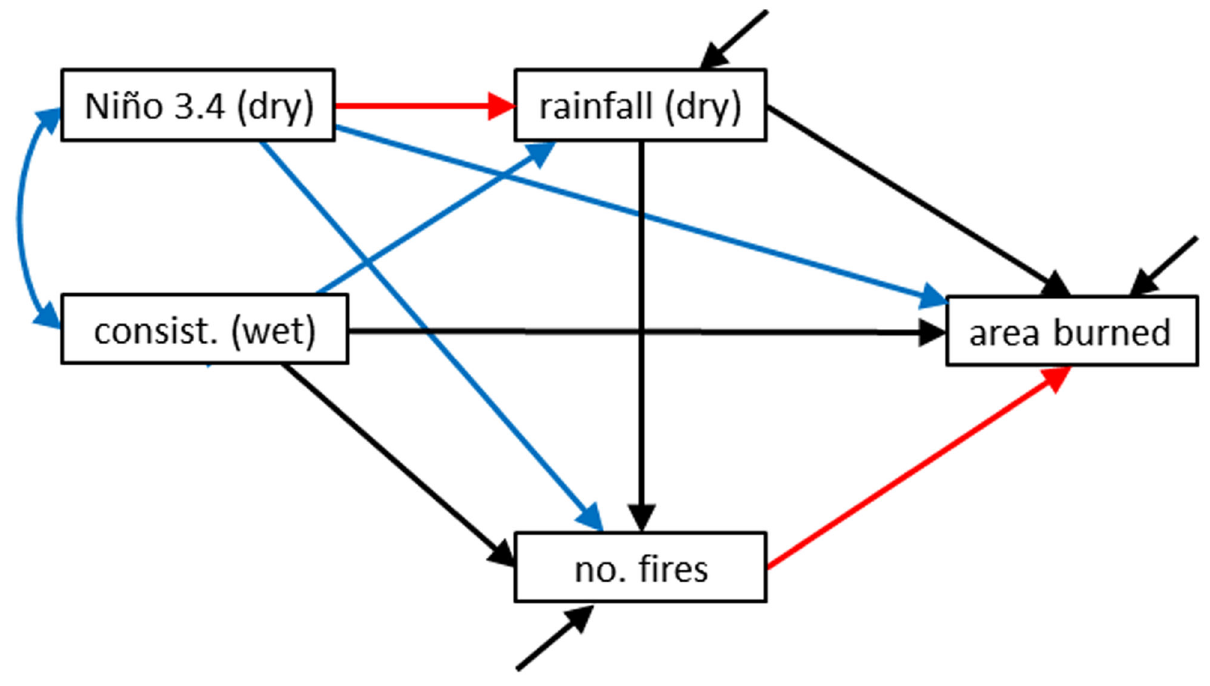
Figure 2. Conceptual model describing how ENSO and seasonal climate govern the wildfire regime. Included in the model are climate variables found to be important in the previous study [2], including Niño 3.4 (measured over the dry season), dry-season rainfall, and the consistency of the moistening trend in the previous wet season. Black and red arrows represent predicted negative and positive effects, respectively, and together make up our starting, theory-based model. Blue arrows were then added to the framework to saturate it for use in exploratory models produced by Amos’s model specification procedure. doi: